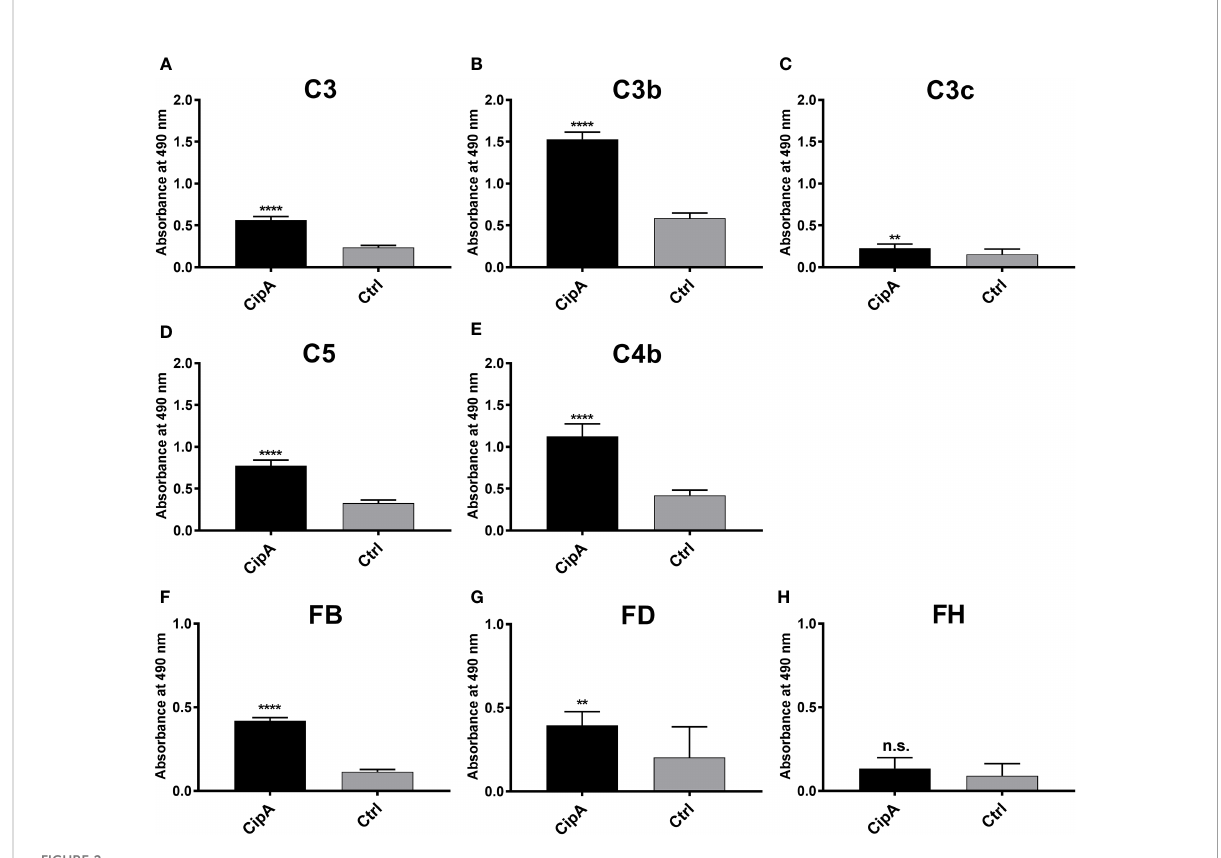
FIGURE 2 Binding of CipA to different complement components of the AP and CP. Protein binding of C3 (A) , C3b (B) , C3c (C) , C5 (D) , C4b (E) , FB (F) , FD (G) , and FH (H) , respectively, to CipA to was measured by ELISA. CipA (5 ng/µl) was immobilized and incubated with 5 ng/µl puri fi ed complement components and BSA or gelatine were used as negative controls (ctrl). Bound complement components were detected using speci fi c antisera (1:1,000). To assess statistical signi fi cance, two-tailed, unpaired Student ’ s t-test was performed. Data represent means and/or standard deviation of at least three different experiments, each conducted in at least triplicate. **, p ≤ 0.05; ****, p ≤ 0.0001; n.s., no statistical signi fi